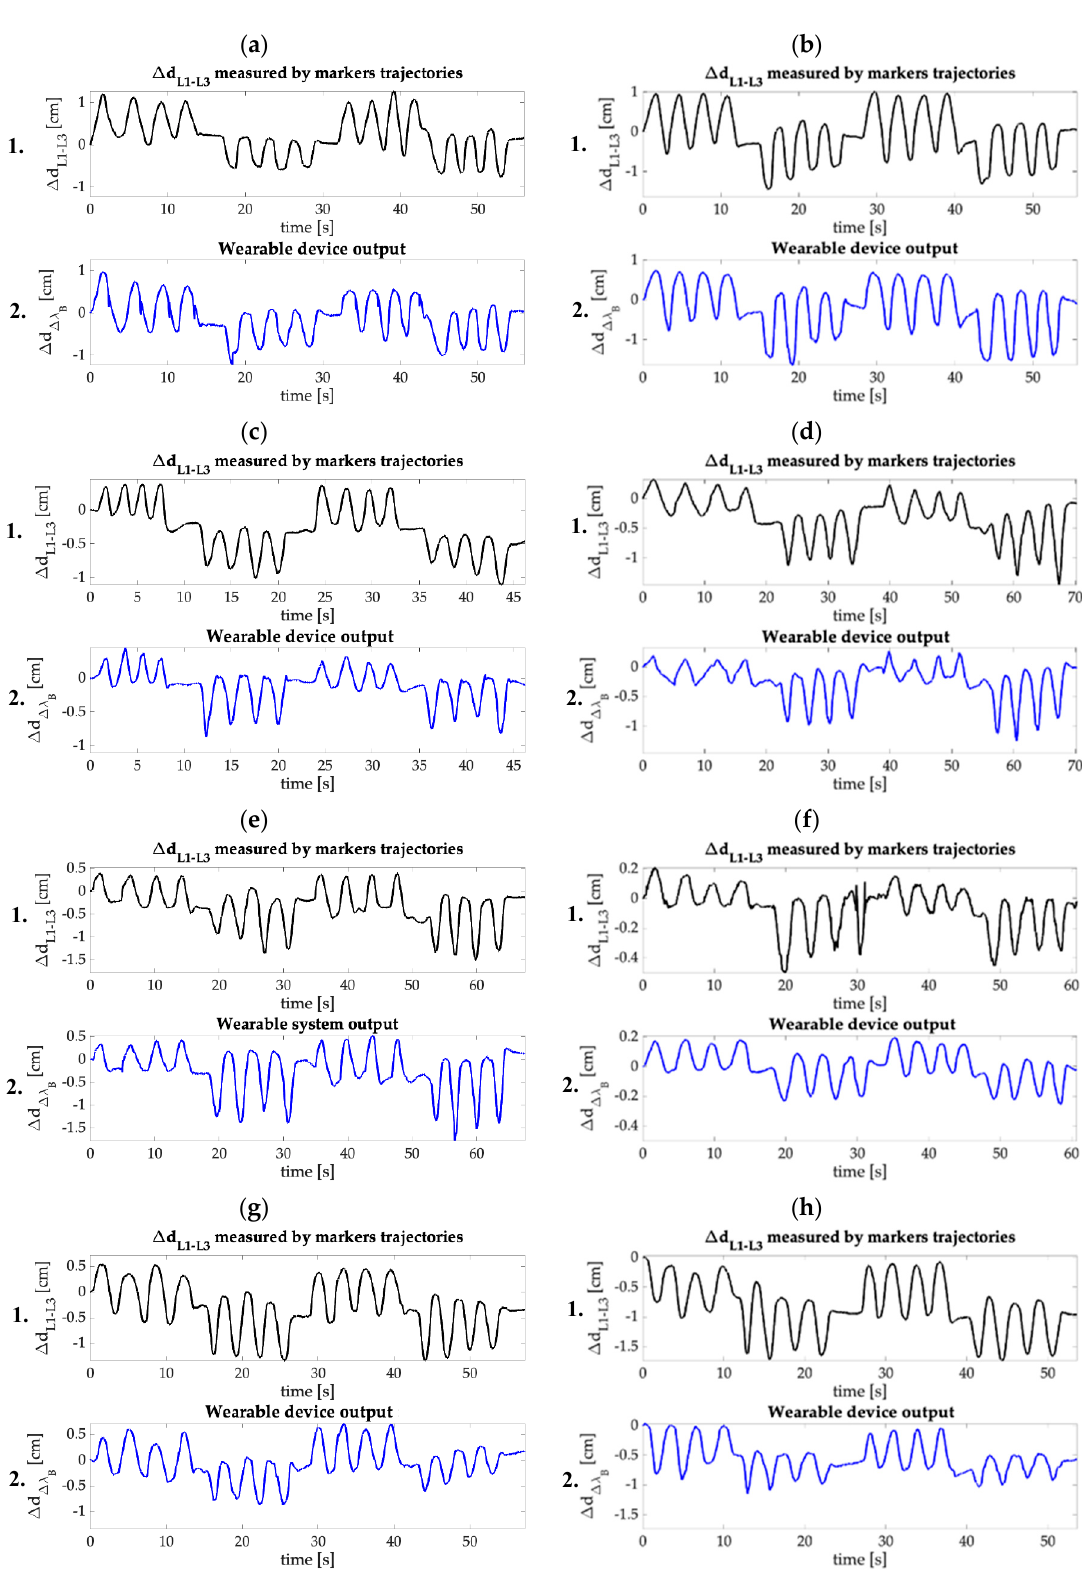
Figure 8. ( 1 ) The distance between L1 and L3 evaluated by the MoCap ( ∆ d L3 − L1 ) and ( 2 ) the reconstructed distance ( ∆ d ∆ λ B ) obtained per each trial. ( a ): Trial 1; ( b ): Trial 2; ( c ): Trial 3; ( d ): Trial 4; ( e ): Trial 5; ( f ): Trial 6; ( g ): Trial 7; ( h ): Trial 8.